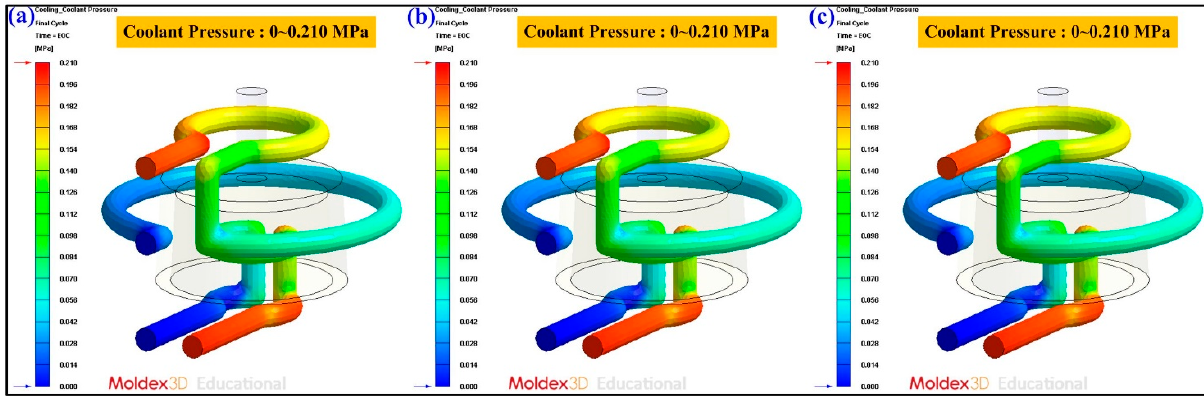
Figure 15. Numerical simulation results of the coolant temperature difference for ( a ) conventional SRM, ( b ) SRM with 60 wt.% Al powder, and ( c ) SRM made with recipe 4.